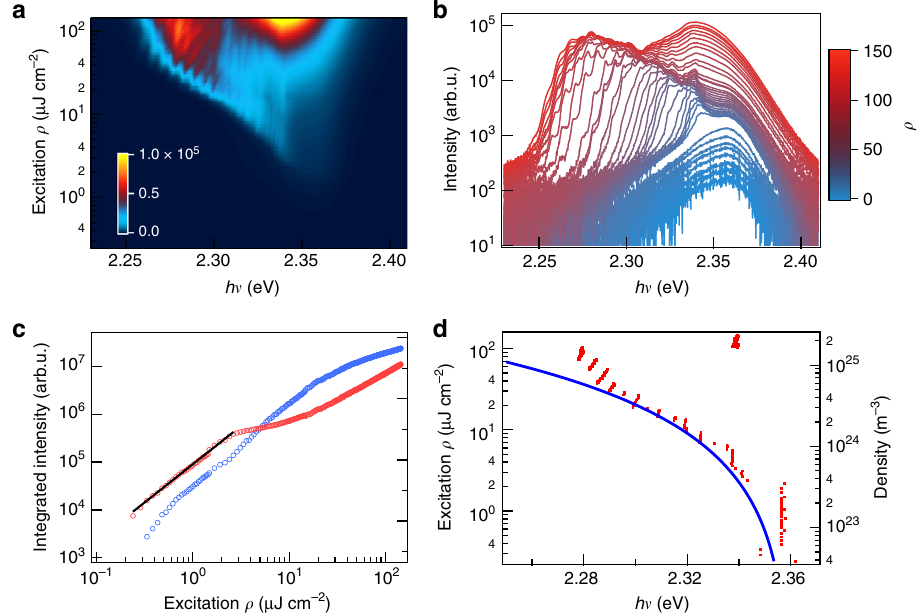
Fig. 2 Excitation density-dependent lasing spectra revealing lasing and saturation thresholds. Two-dimensional pseudo-color plot ( a ) and horizontal cuts ( b ) of photoluminescence spectra as a function of increasing excitation energy density ( ρ ), 0.24 – 145 µ J cm − 2 . The excitation energy density in ( b ) increases from blue to red (0.43, 0.53, 0.62, 0.77, 1.0, 1.1, 1.3, 1.5, 2.4, 2.6, 2.9, 3.1, 3.6, 4.3, 5.3, 6.5, 7.2, 7.9, 8.6, 9.6, 11.0, 12.5, 13.9, 15.4, 17.3, 19.7, 21.6, 24.0, 33.1, 37.9, 49.9, 61.9, 71.5, 83.5, 95.5, 107.5, 119.5, 131.5, 144.0 µ J cm − 2 ). Note the logarithmic scale for emission intensity in ( b ). These spectra show the evolution of emission from below the lasing threshold (3 μ J cm − 2 ) through the lasing saturation threshold (30 μ J cm − 2 ) and above. Stimulated behavior is con fi rmed from the PL intensity as a function of excitation density ( c ), showing the integrated intensity in the lasing spectral region (blue) where the onset of lasing corresponds to superlinear behavior and saturation of the PL intensity (red). An exponential fi t (black line) represents the power scaling law of ρ 1.5 present below the lasing threshold. As pump fl uence increases, the lasing spectral density red-shifts, as shown by the positions (red dots) of the most intense peak in lasing/PL spectra as a function of excitation density ( d ). The blue curve in ( d ) shows fi t to the excitation density-dependent plasmon energy. All spectra were obtained from a single NW with 15 µ m length at a substrate temperature of 80 K